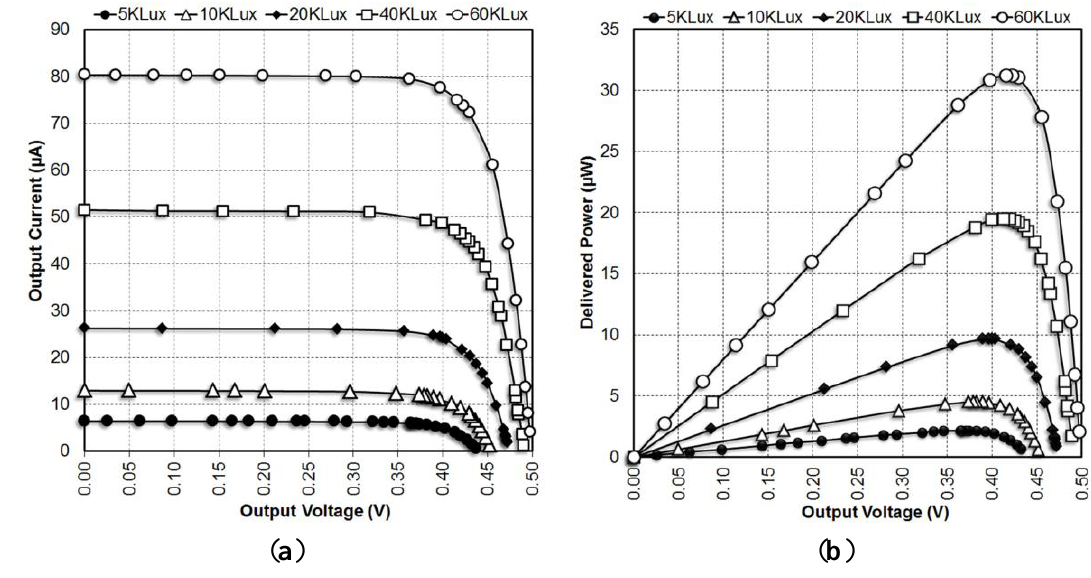
Figure 11. Measured output voltage vs. output current ( a ) and output power of the solar cell array ( b